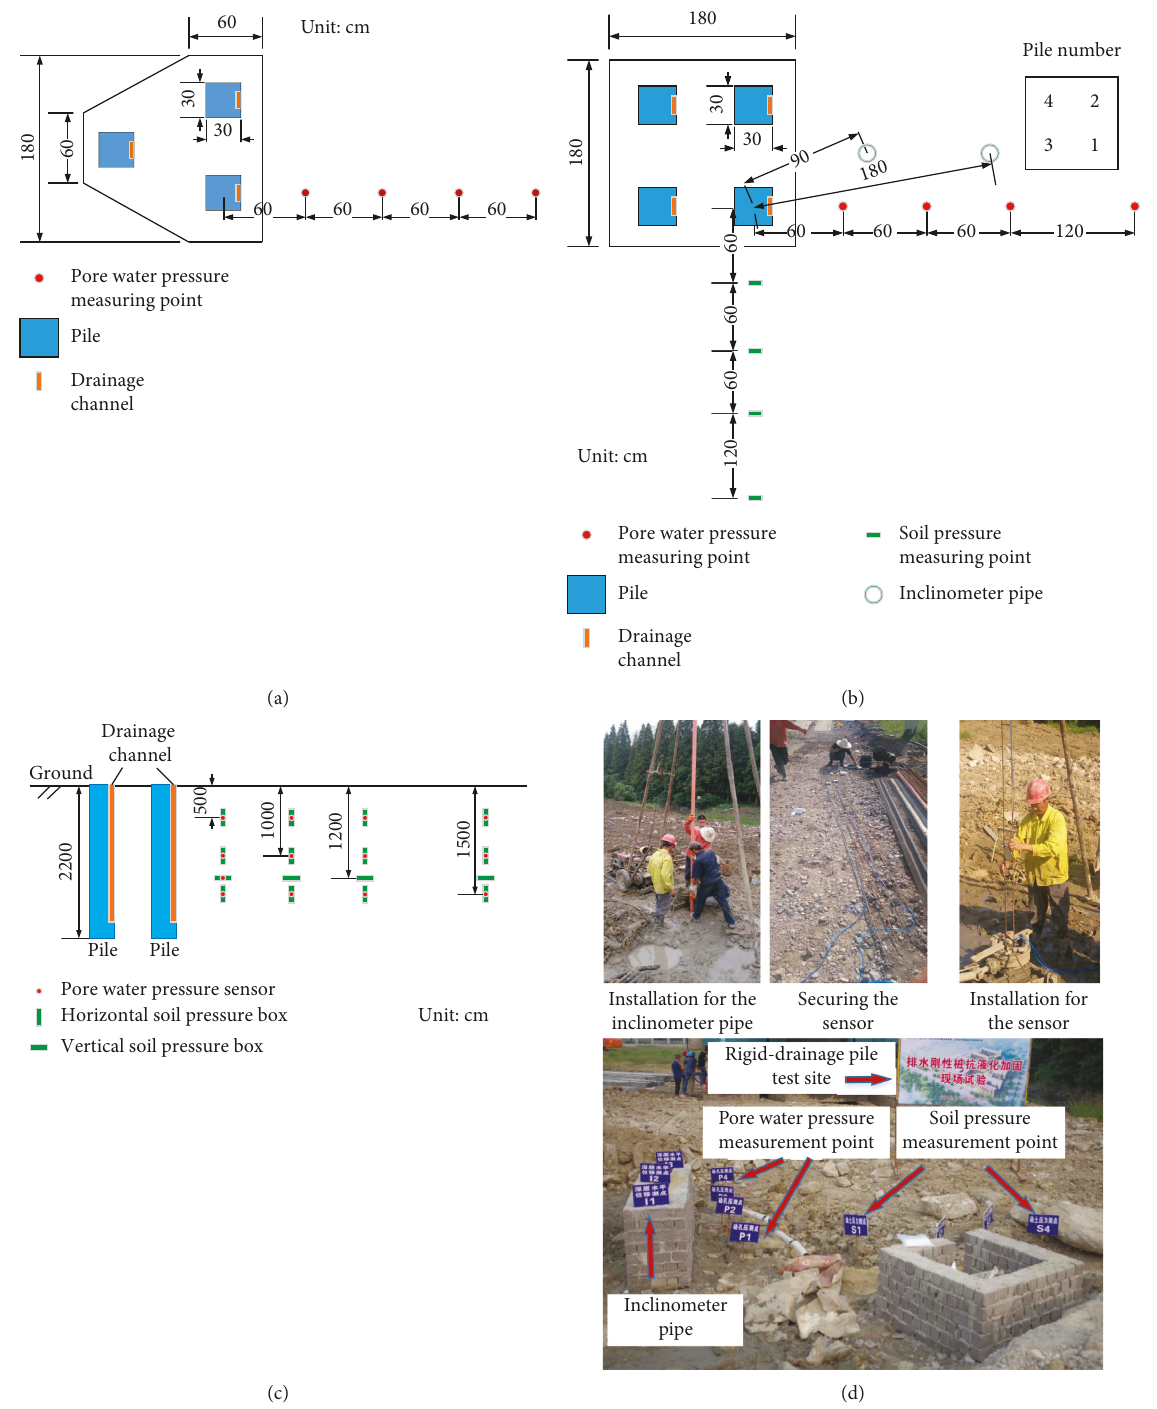
Figure 4: Sensor arrangement. (a) Three-pile cap. (b) Four-pile cap. (c) Vertical arrangement. (d) Field